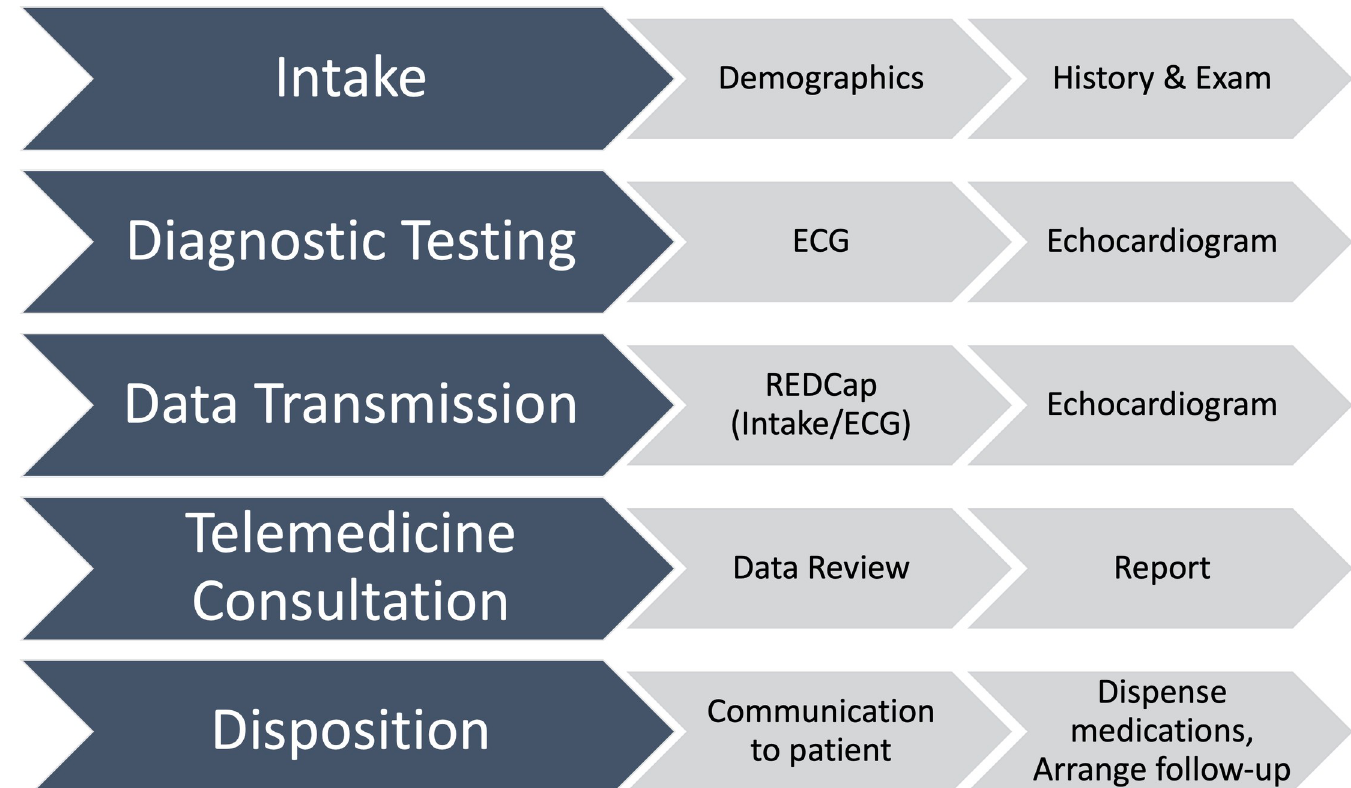
Fig 2. Telemedicine technical flow. This figure depicts the digital flow for the telemedicine process. Abbreviations: DICOM–Digital Imaging and Communications in Medicine; GSM–Global System for Mobile Communications; MPEG–Moving Picture Experts Group; PACS–Picture Archival and Communication System; US–